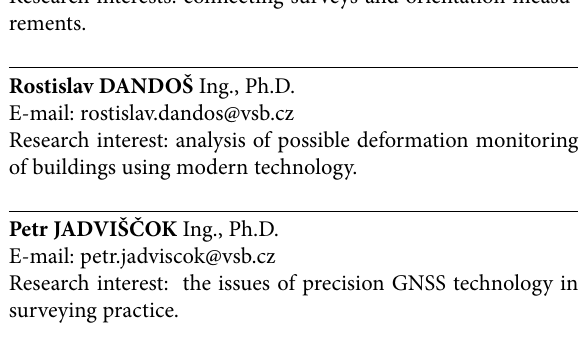
Table 5. Values of the differences in elevation between fixed points, ČSA 2 shaft, Mine Karviná 1 st method